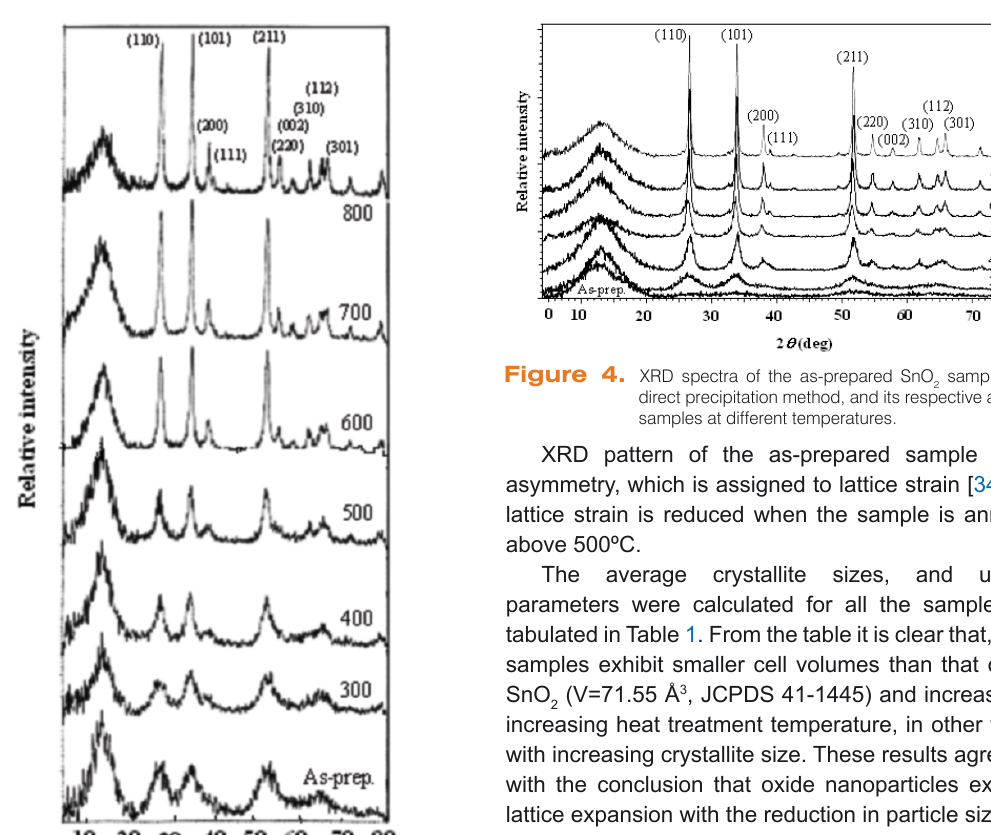
sample, using citric 2